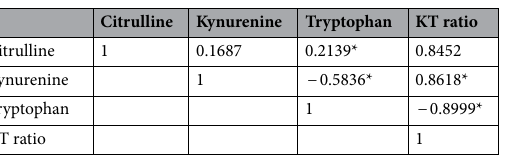
Table 2. The correlation coefficient for gut health biomarkers at enrollment. KT kynurenine: tryptophan. * P value < 0.05.